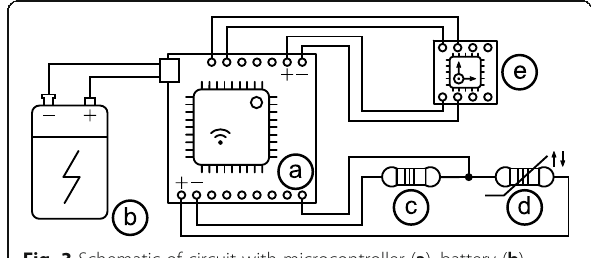
Fig. 3 Schematic of circuit with microcontroller ( a ), battery ( b ), reference resistor ( c ), thermistor ( d ) and acceleration module ( e